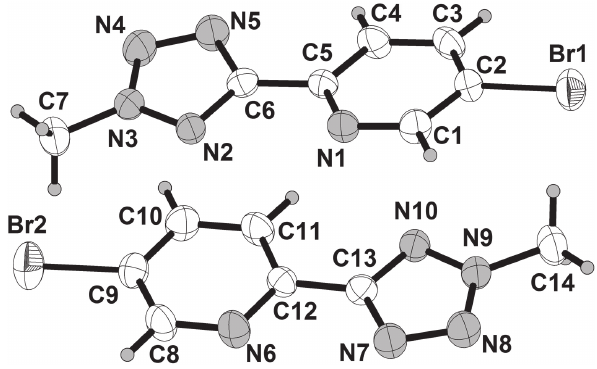
Table 1: Data collection and handling.